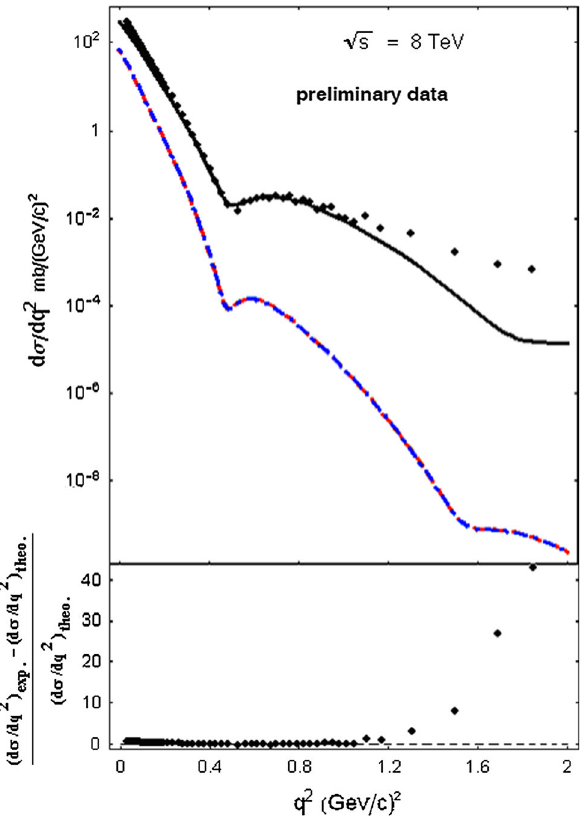
Fig. 3 Same as Fig. 1 for 13 TeV. The experimental data are taken from